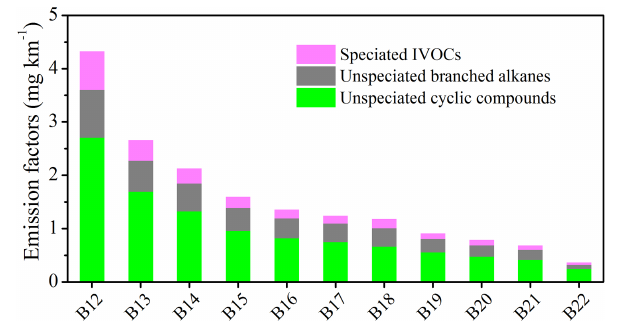
Figure 3. The average emission factor of vehicular IVOCs in dif- ferent bins measured during the campaign.